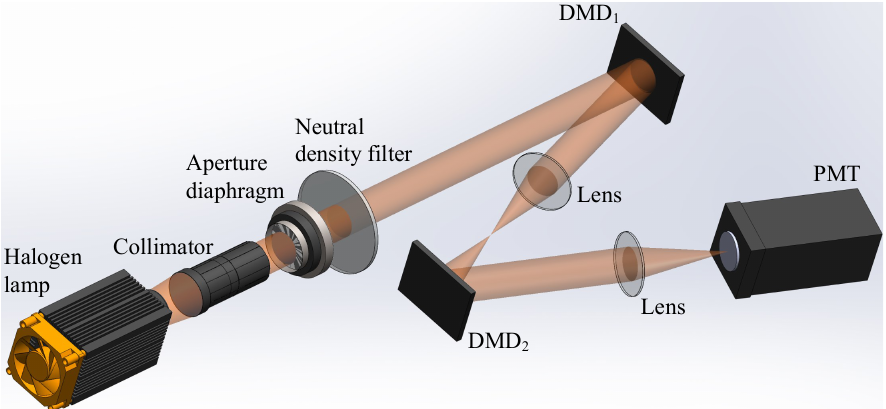
Figure 7. Experimental setup of computational GI. DMD: digital micromirror device, PMT: photo- multiplier